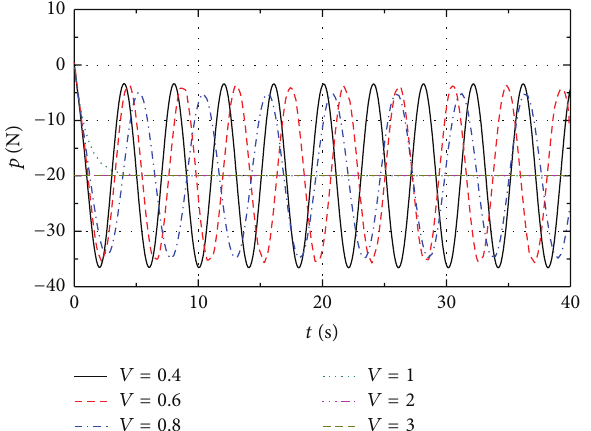
is a constant 𝑚𝑔 (as shown in Section 4); the contact force for sonic velocity decays exponentially and tends to 𝑚𝑔 , while the contact force for subsonic velocities is oscillating. As shown in Section 3, for subsonic velocities, there exists an asymptotical solution for the contact force when the time tends to infinity.